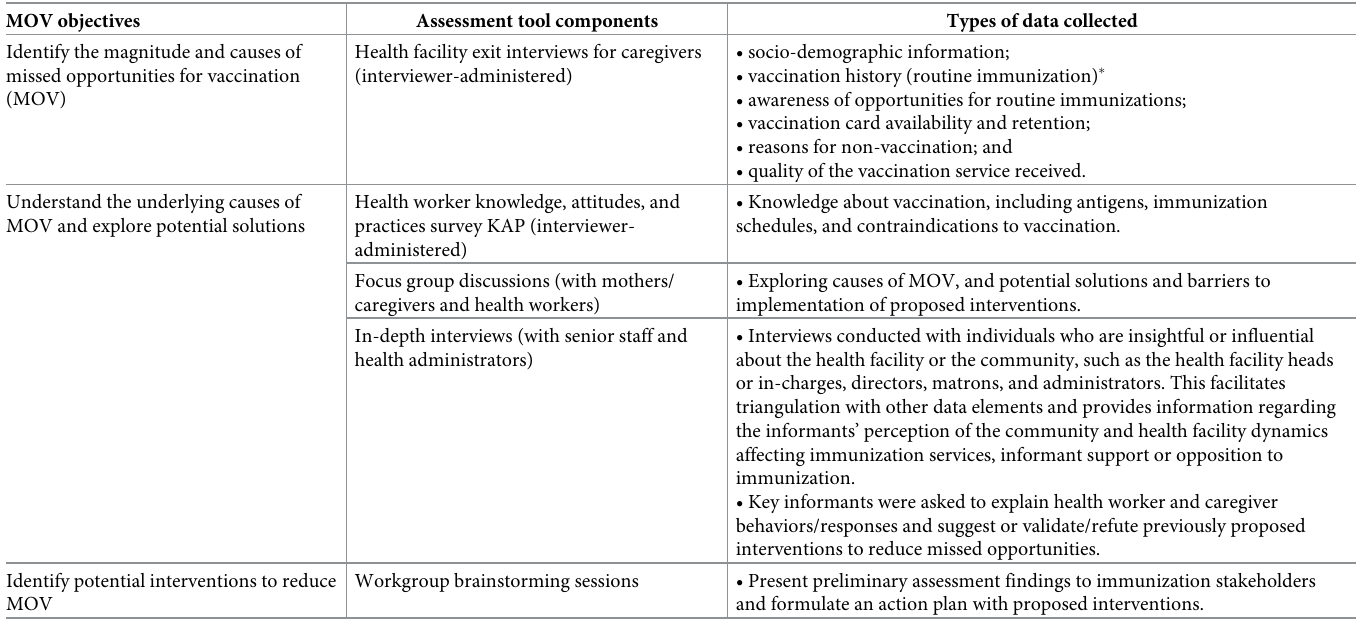
Table 1. Matrix for implementing the Missed Opportunities for Vaccination (MOV) Assessment, Ondo State, Nigeria, 2019. MOV